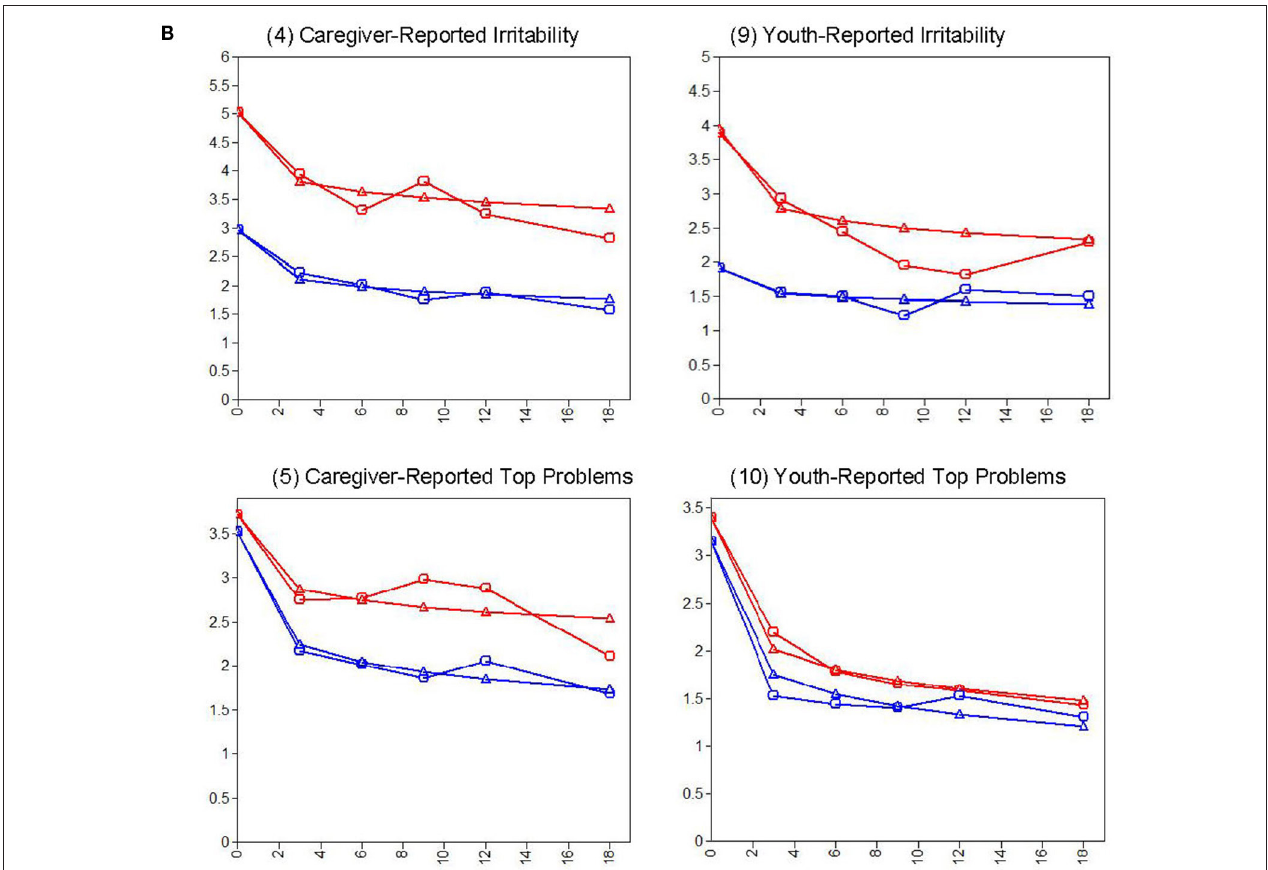
FIGURE 2 | (A) CBCL and YSR problem trajectories for youth in the high dysregulation (Red) and low dysregulation (Blue) groups over time (0 to 18 months). Models control for the covariates noted previously (Table 2) . (B) Irritability and top problem trajectories for youth in the high dysregulation (Red) and low dysregulation (Blue) groups over time (0 to 18 Months). Models control for the covariates noted previously (Table 2)